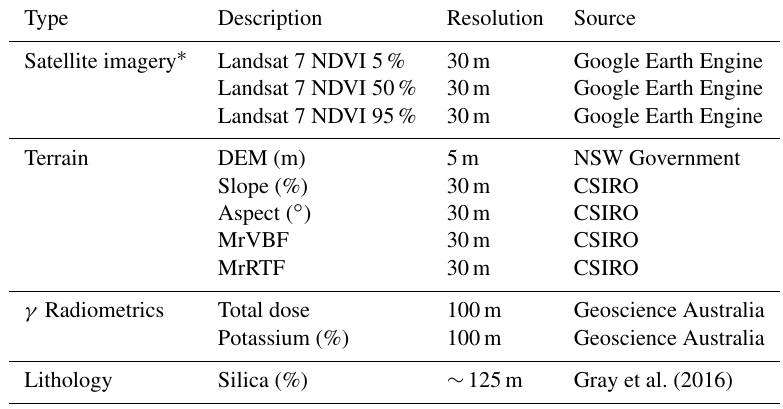
Table 2. Description and source of covariates used for digital soil